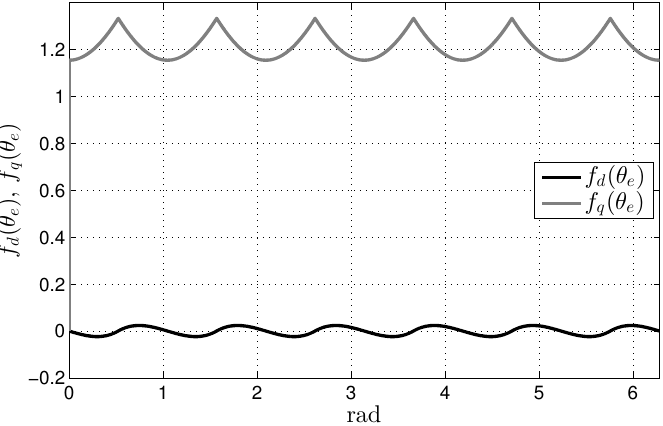
Figure 2. Back-EMF fundamental functions f d ( θ e ) and f q ( θ e ) in ( d , q ) reference